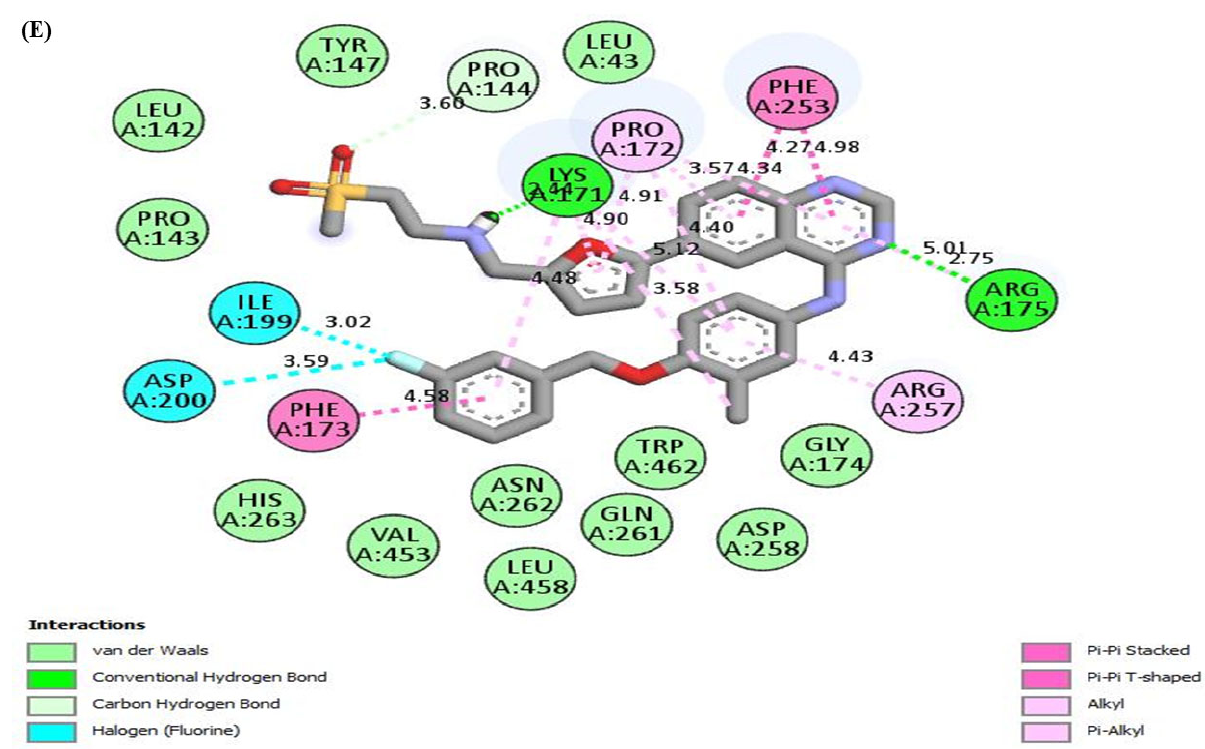
Figure 2. 2D Molecular interaction of human G6PD with ( A ) Polydatin, ( B ) Withanoside II, ( C ) With- anoside IV, ( D ) Staurosporine and ( E ) Lapatinib.